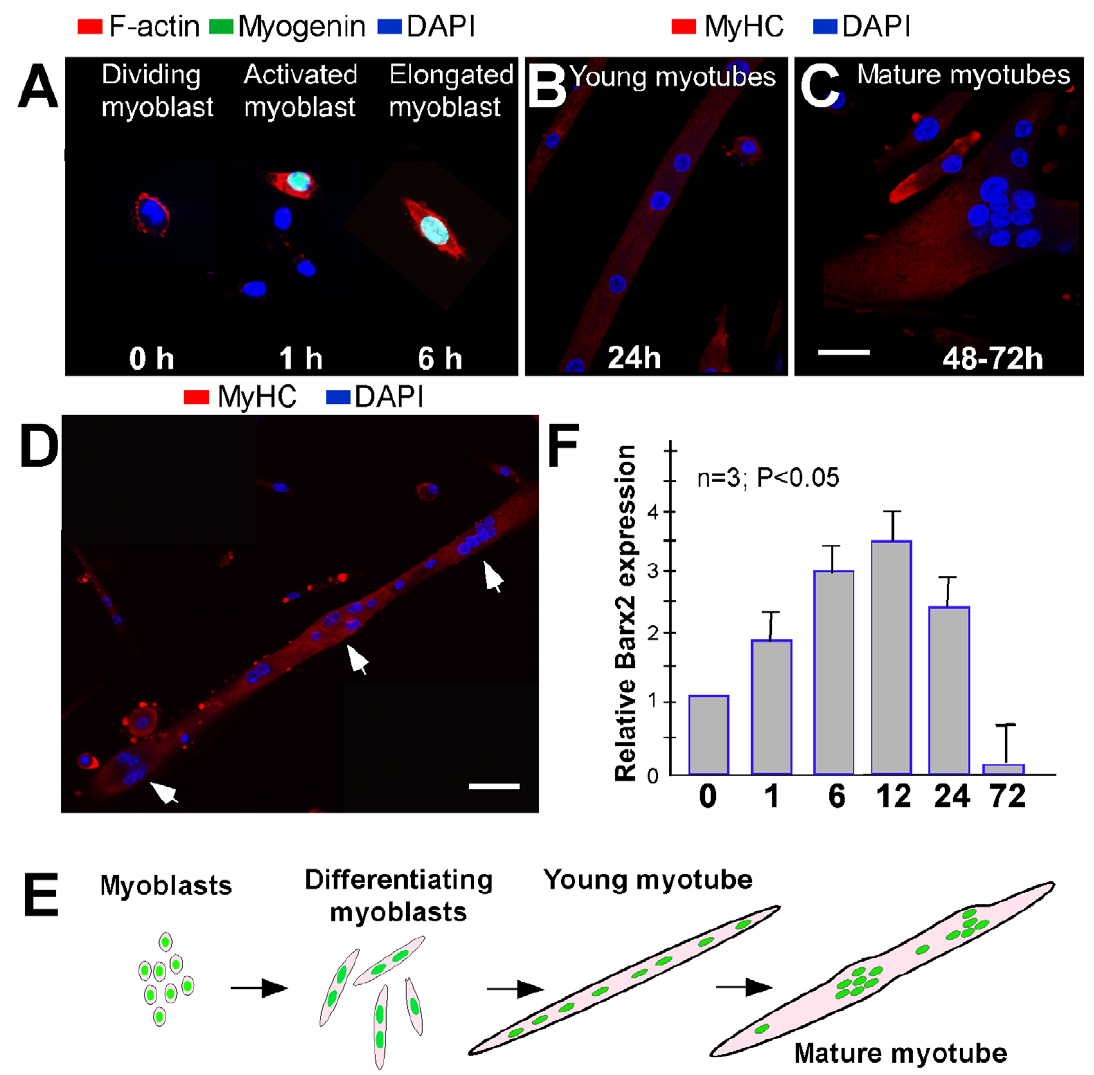
Figure 2. Differentiating myoblasts and maturating myotubes have different levels of Barx2 expression. A. Cultured primary myoblasts were induced to differentiate by serum withdrawal and changes in cell shape, actin remodeling and myogenin expression were monitored over the first 6 hours. B–D. Myotube maturation was examined between 24 and 72 hours post serum-withdrawal. At 24 hours myotubes were thin and appeared immature ( B ). Between 48 and 72 hours, thicker myotubes appeared often with local aggregations of nuclei ( C and D ) and frequent strong contractions. E. Observations of myotube maturation in culture presented schematically. F. Barx2 expression was measured by RT-PCR at different stages of differentiation. Scale bars represent (A–C) - 20 m m, D–50 m m.